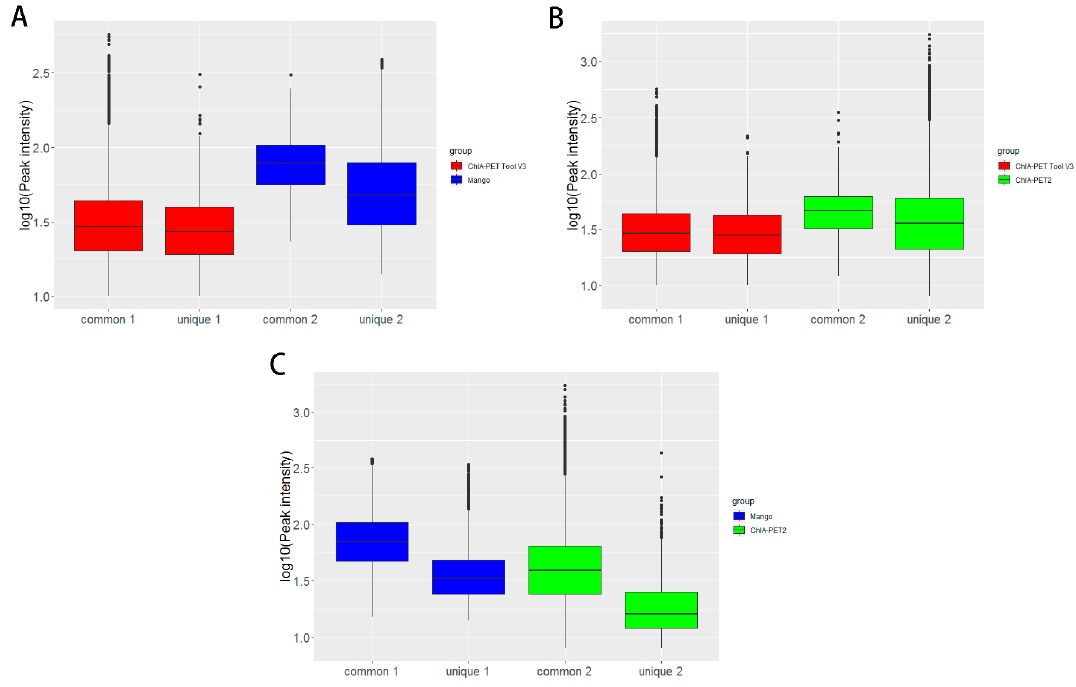
Figure 12. Box plots of peak intensities between different tools from human K562 cells. ( A ) Peak intensity between ChIA-PET Tool V3 and Mango. ( B ) Peak intensity between ChIA-PET Tool V3 and ChIA-PET2. ( C ) Peak intensity between Mango and ChIA-PET2. The common part represents peak intensities with overlap between two tools. The unique part represents peak intensity without overlap between two tools. Middle line denotes median; box denotes Interquartile Range (IQR); whiskers denote 1.5 × IQR.